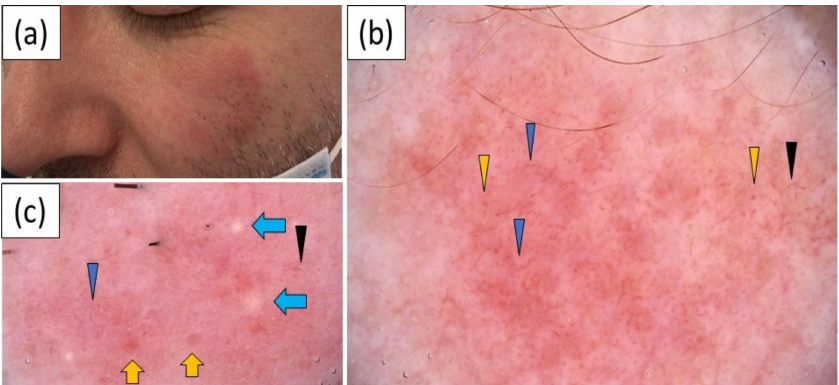
Figure 4. ( a ) Clinical presentation of lupus erythematosus tumidus on the left cheek; ( b ) videoder- moscopy showing dotted (yellow arrowhead), linear (blue arrowhead) and linear branched (black arrowhead) vessels on a pink–red background; ( c ) videodermoscopy showing linear (blue arrow- head) and linear branched (black arrowhead) vessels, white–yellowish globules (blue arrows) and orange–reddish globules (yellow